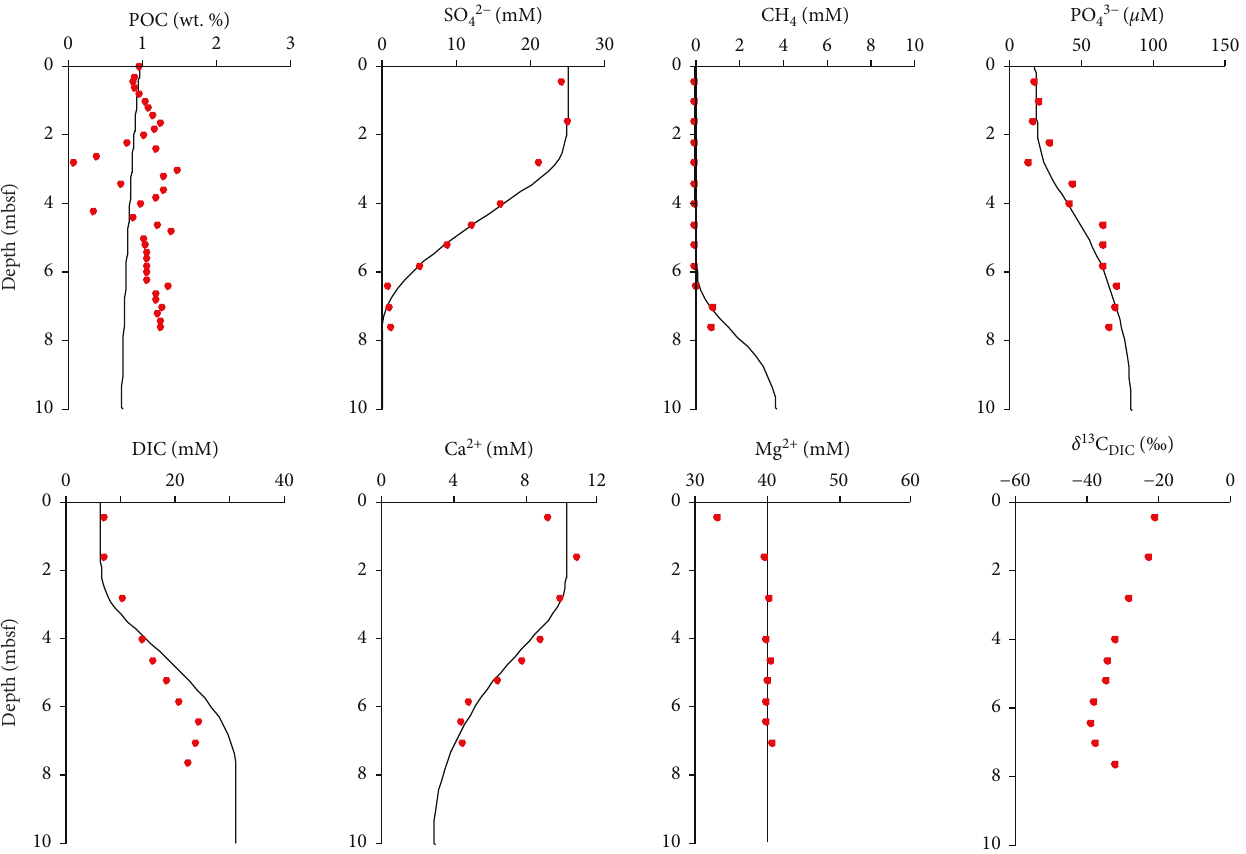
Figure 4: Measured (dots) and simulated (curves) depth pro fi les of core CL47. Down-depth concentration of POC, SO 42- , CH is Ca 2+ , Mg 2+ , and δ 13 C DIC